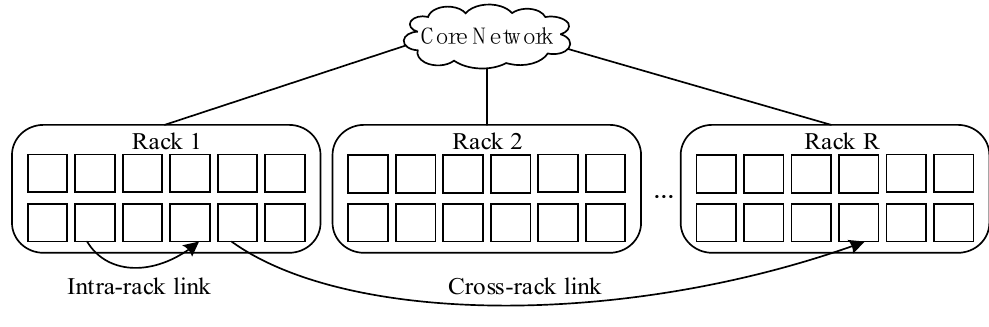
Figure 1. Hierarchy in the data center .